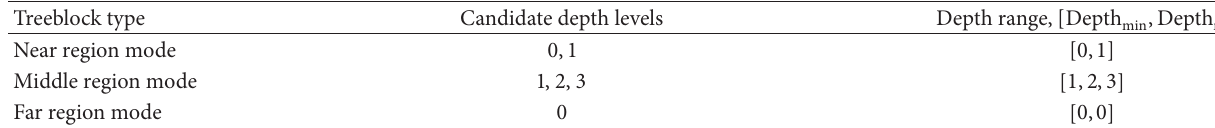
Table 2: Candidate depth levels for three treeblocks types.